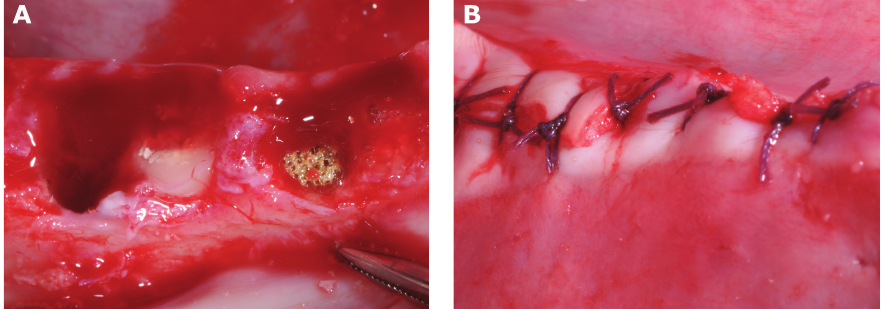
Figure 1: Clinical photographs illustrating the sham and sca ff old sites (A) and the socket sites covered by mucosa flaps that were retained in position with interrupted sutures (B).